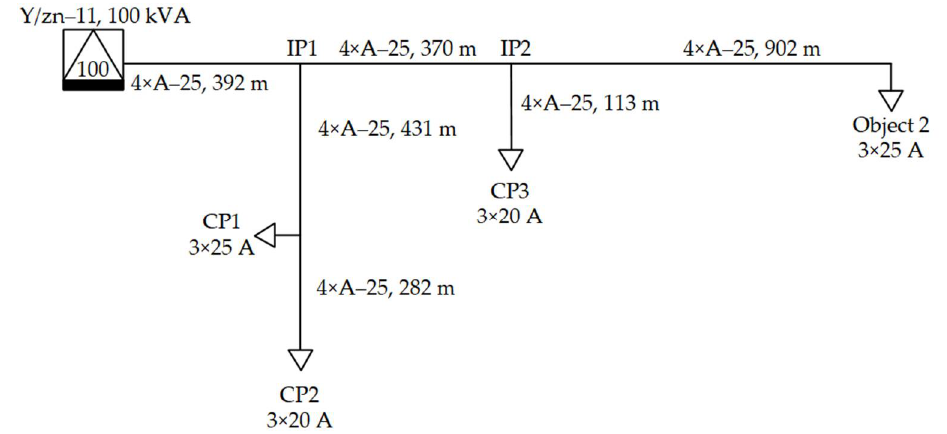
Figure 6. DIgSILENT PowerFactory single-line diagram model representation of Grid 2 from Group 2, representing a typical low voltage feeder with relatively high one phase short-circuit impedances and shortest distances to consumers.